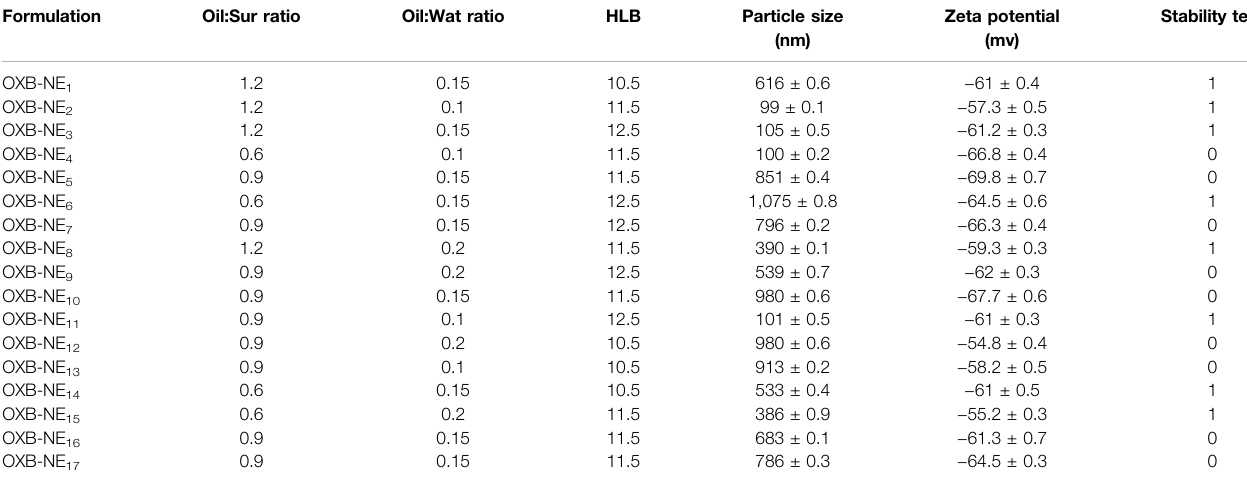
TABLE 1 | Nanoemulsion ingredients, particle size, zeta potential, and stability study results (mean ± SD, n = 3). Formulation Oil:Sur ratio Oil:Wat